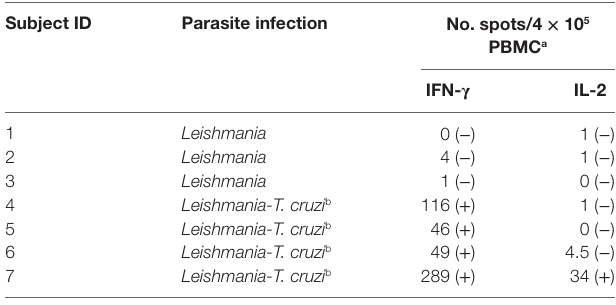
TaBle 4 | IFN- γ and IL-2-secreting T-cells in response to a T. cruzi lysate in patients with Tegumentary